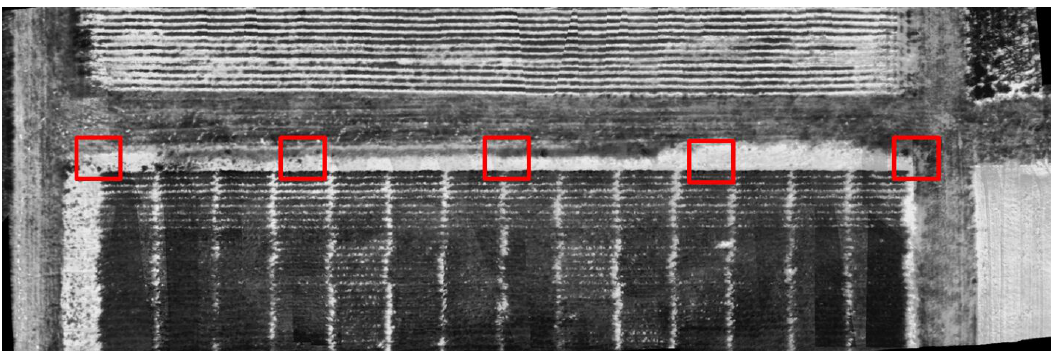
Figure 18. Orthophoto result while ignoring the time delay using the refined trajectory data for FLIR thermal July 25th data collection (red boxes show the location of the check points, Orignal Image GSD ≈ 0.03 m ).